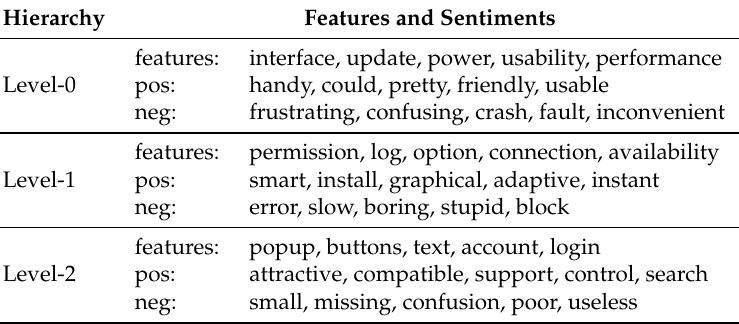
Table 1. Hierarchical requirement features with sentiment